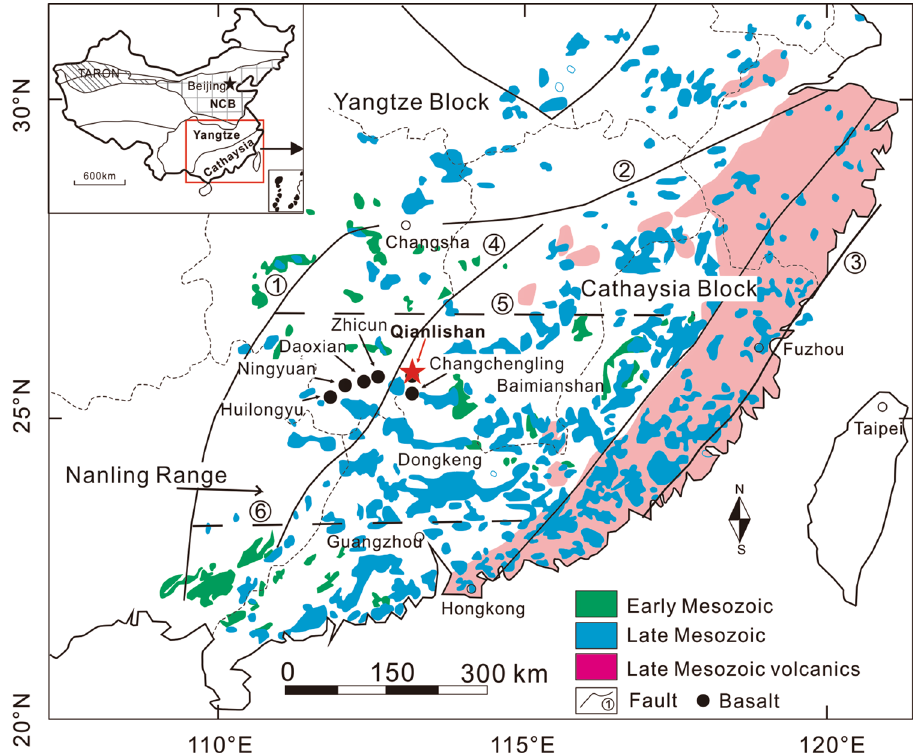
Figure 1. Geological map of the Nanling Range, South China (modified after Chen et al. (2016) 14 , copyright@ Elsevier, 2016). Faults: ( 1 ) Jiangshan–Shaoxing-Pingxiang Fault; ( 2 ) Zhenghe-Dapu Fault; ( 3 ) Changle-Nan’ao Fault; ( 4 ) Chenzhou-Linwu Fault; ( 5 ) Changlin-Guangchang buried Fault; ( 6 ) Wuzhou-Sihui buried